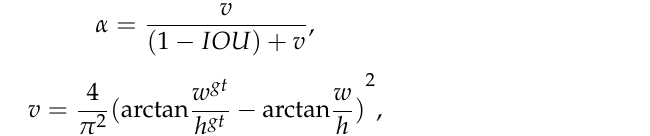
Figure 1. YOLOv4 network structure diagram. * represents multiply.